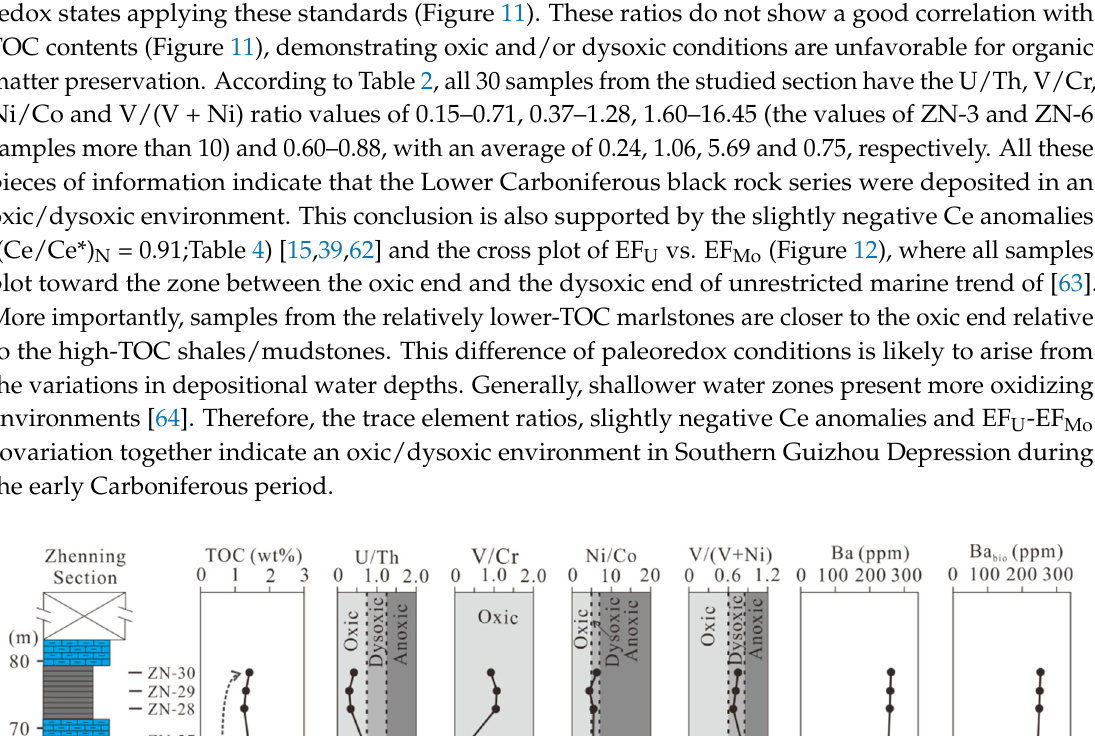
Figure 12. Cross plot of EF U vs. EF Mo , showing that samples from the studied section plot toward the zone between the oxic end and the dysoxic one. Base figure modified from [63]. The diagonal dashed lines represent Mo/U molar ratios of the seawater (Sw). 5.4. Paleoclimatic Conditions Previous research has suggested that the relative contents and distribution of some major and TEs in fine-grained rocks could infer the paleoclimatic conditions [6,15,39,65]. A consensus has been achieved by previous studies [15,39,66] that Fe, Mn, V, Cr, Co, and Ni are relatively enriched under moist climatic conditions. On the contrary, the upwelling of water alkalinity owing to evaporation under arid climatic conditions facilitates saline minerals to precipitate, so elements like Ca, Mg, Na, K, Ba, and Sr are comparatively concentrated. In consideration of the diverse geochemical behaviors of these two groups, their ratios of Σ (Fe + Mn + Cr + Ni + V + Co)/ Σ (Ca + Mg + Sr + Ba + K + Na) (named as C-value) are regarded as a climate proxy and have been widely applied to interpreting